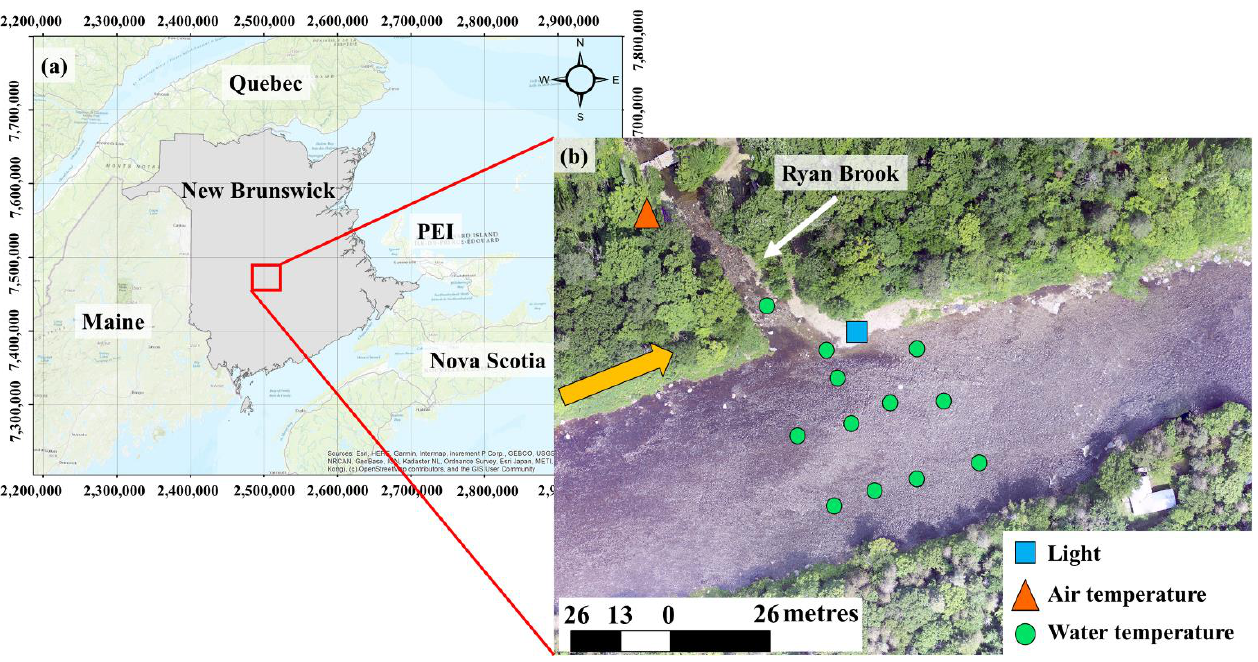
Figure 2. The Nashwaak River’s location in New Brunswick, Canada ( a ), and a fine-scale UAV optical image detailing the study site ( b ). The yellow arrow denotes the river’s flow direction, and the groundwater-dominated tributary “Ryan Brook” is highlighted by the white arrow. Logger locations are indicated by various shapes (see legend).